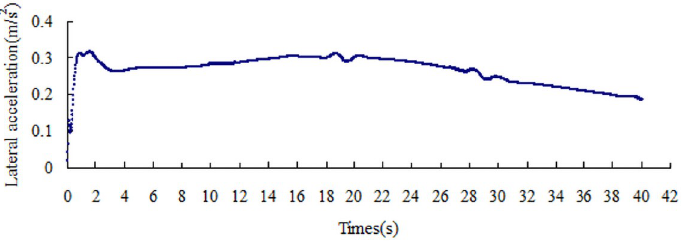
Fig 11. Lateral acceleration change graph of friction coefficient 0.4.